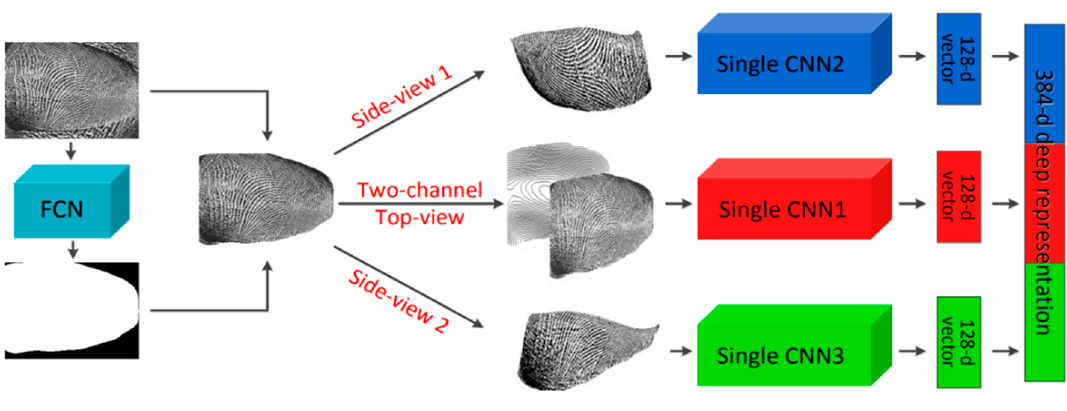
Figure 11. Automatic learning of 3D fingerprint features via deep representation [86].